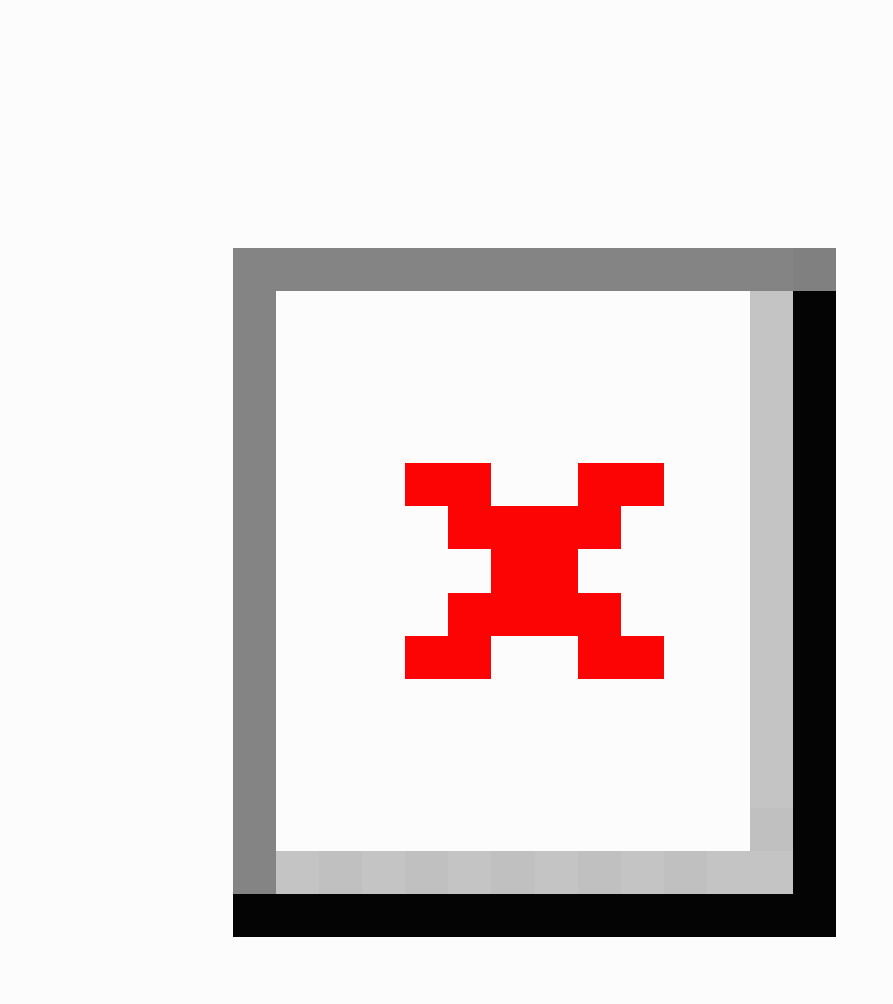
Figure 2. Example of virtual grocery store